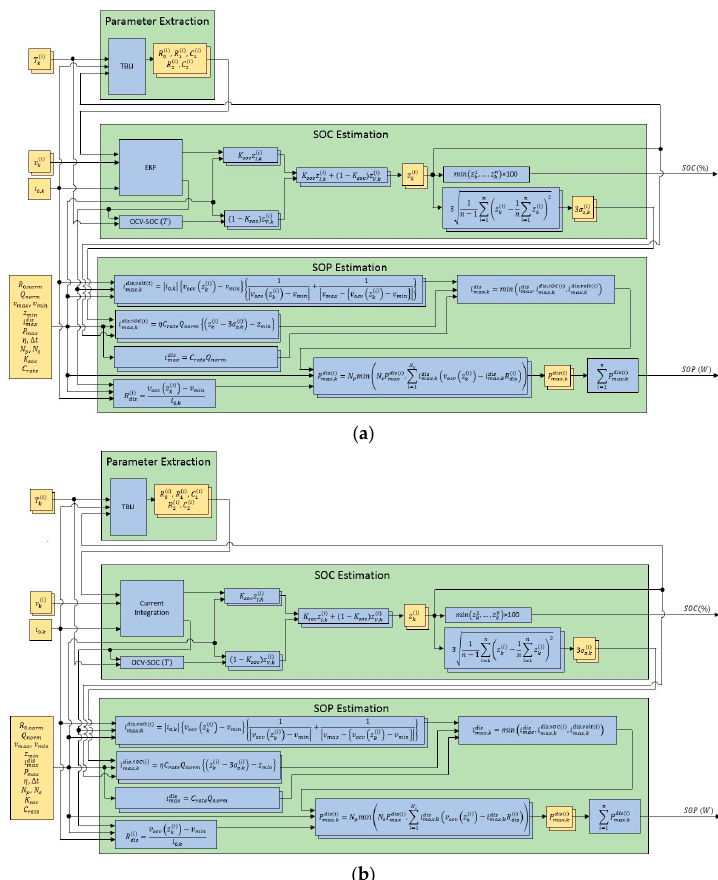
Figure 4. Overall SOC and SOP state estimation logic: ( a ) without EKF; and ( b ) with EKF.